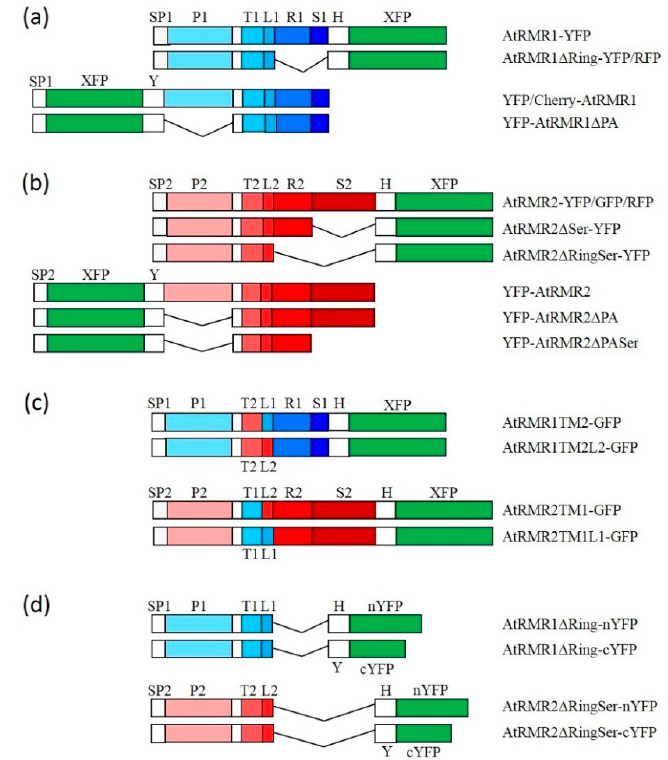
Figure 1. Schematic representation of the fluorescent AtRMR (Receptor Membrane RING-H2) fusion proteins generated in this work. All these fusion proteins were over-expressed in Nicotiana benthamiana leaves under the control of the cauliflower mosaic virus (CaMV) 35S promoter and terminator. ( a ) C- and N-terminal fusions of fluorescent proteins to AtRMR1 and to its mutants deleted for the Protease-Associated (PA) domain or the RING-H2 domain along with the short Ser-Rich tail; ( b ) C- and N-terminal fusions of fluorescent proteins to AtRMR2 and to its mutants deleted for the PA, the Ser-Rich or the RING-H2 domains; ( c ) AtRMR1 and -2 mutants with the transmembrane domain or both the transmembrane domain and the linker sequence swapped; and ( d ) constructions for Bimolecular Fluorescent Complementation (BiFC) detection of AtRMR1 and -2 lacking their cytosolic domains (RING-H2/Ser-Rich) and fused to either half of YFP. Abbreviations (numbered 1 or 2 for domains of each AtRMR): SP, signal peptide; P, PA-domain; T, transmembrane domain; L, linker sequence; R, RING-H2 domain; S, Ser-Rich domain; XFP, fluorescent protein (YFP, yellow fluorescent protein; RFP, red fluorescent protein; GFP, green fluorescent protein; or Cherry, mCherry fluorescent protein, as indicated); nYFP, N-terminal half of YFP; cYFP, C-terminal half of YFP; H, Gly 6 -HA epitope spacer; Y, Gly 6 -Myc epitope spacer. The main protein domains (P, T, L, R and S) of AtRMR1 and -2 are depicted with different shade of blue and red, respectively, while XFP is depicted in green.